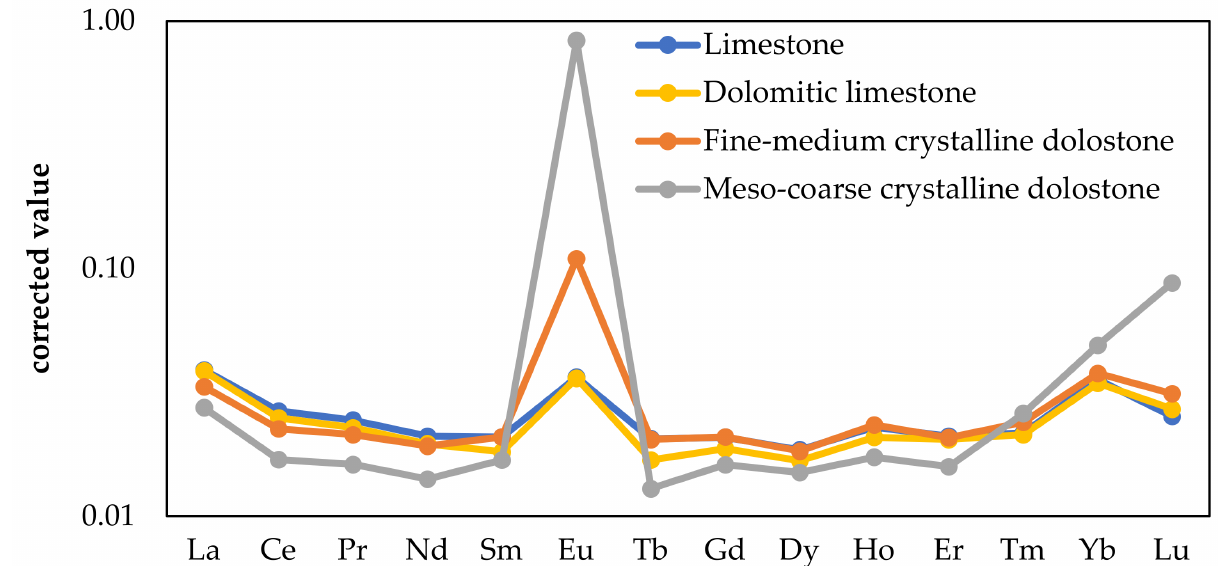
Figure 4. The REE patterns of carbonate rocks from the Qixia Formation (the normalizing values used were those of North-American shale).